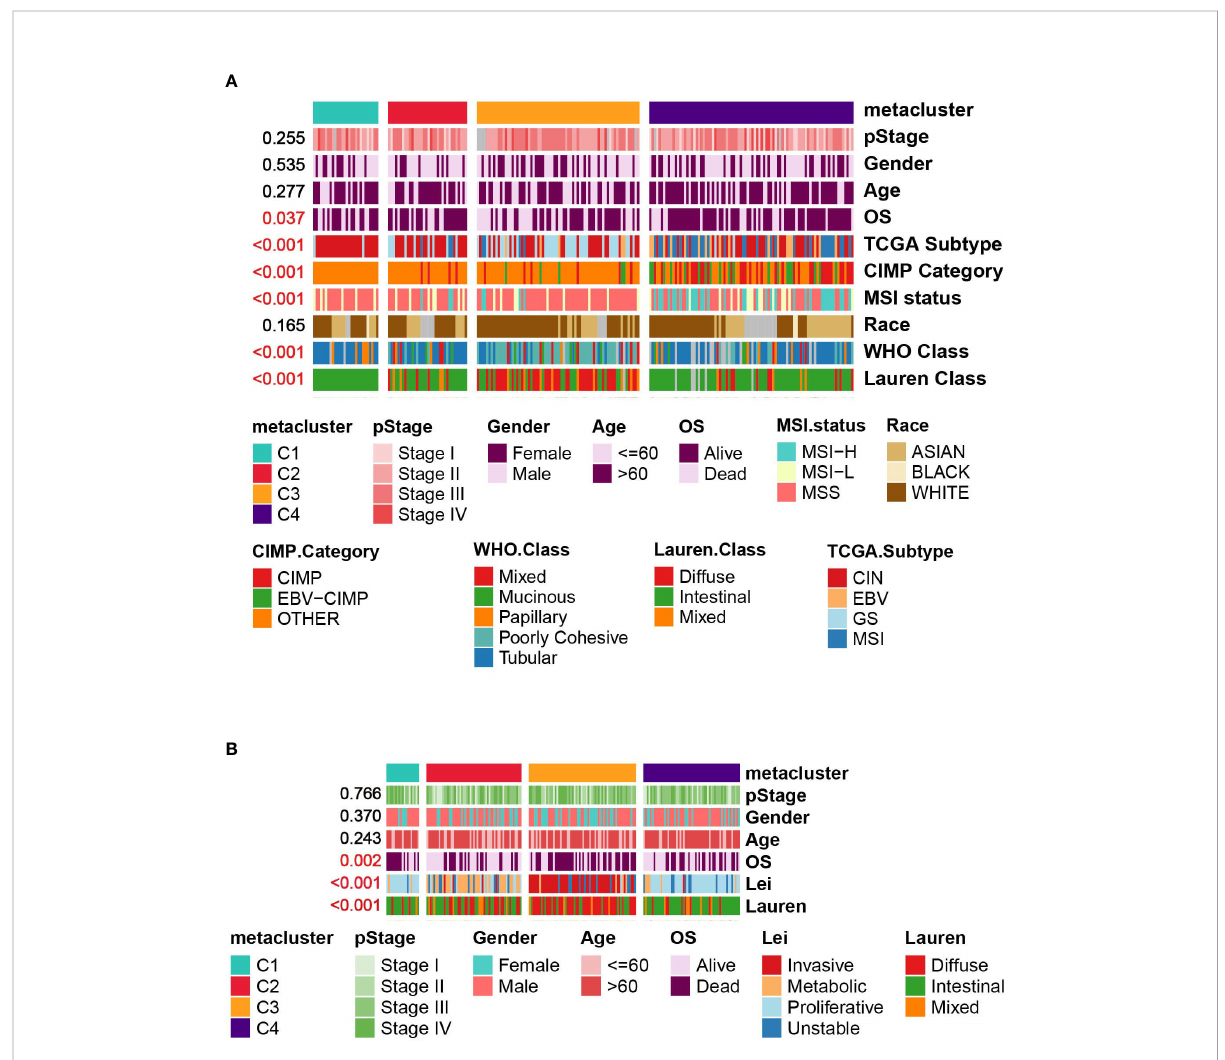
FIGURE 4 Correlation between GC subtypes and clinical characteristics in (A) TCGA cohort. (B) GSE15459